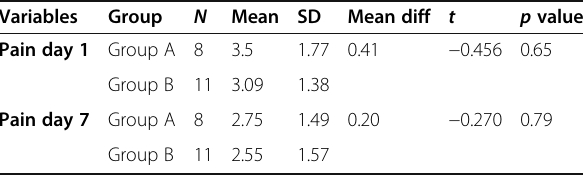
Table 3 Comparison of mean postoperative pain on day 1 and 7 between two groups using the Mann Whitney U test